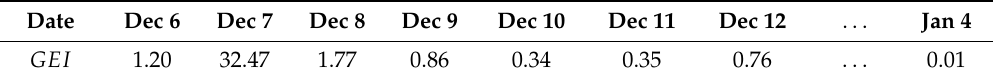
Table 3. Time series of GEI with geo-tagged check-ins identified as ’fitness’.